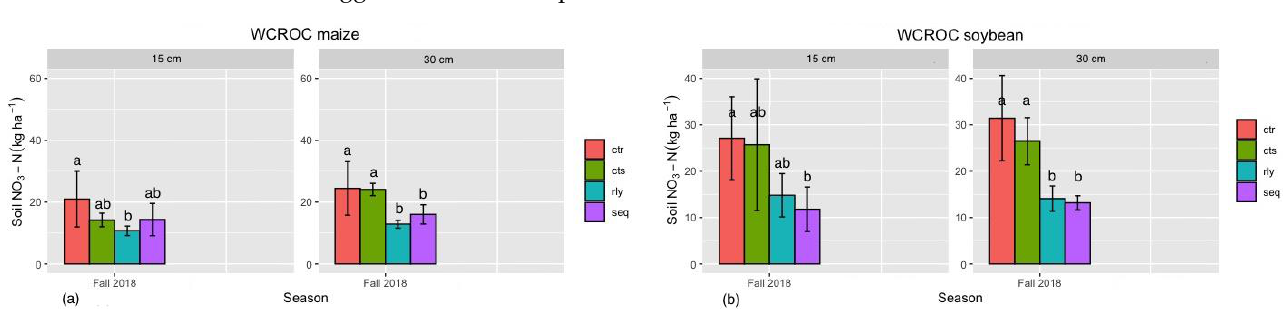
Figure 2. Effects of N–fertilized winter camelina double cropped with maize and soybean on soil available N at two soil layers: ( a ) 0–15 cm and ( b ) 15–30 cm. Vertical lines denote standard deviation. West Central Research and Outreach Center (WCROC) 2018–2019. ctr = control relay, cts = control sequential, rly = relay cropping, and seq = sequential cropping. In a given season and depth within a location, bars followed by different letters are significantly different at p ≤ 0.05.